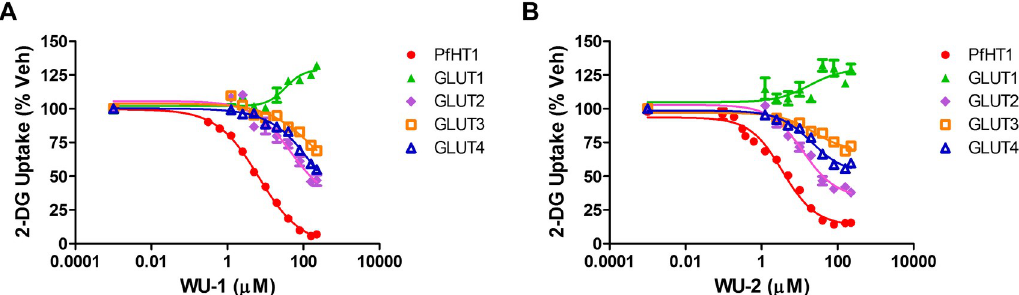
Fig 3. IC 50 determination of glucose uptake by HEK293 cells overexpressing human class I orthologues. 2-DG uptake in response to increasing WU-1 (A) or WU-2 (B) concentrations in HEK293 cells expressing the indicated GLUT protein. IC 50 s were calculated using nonlinear regression analysis using GraphPad Prism 6.0 and are tabulated in Table 1. Uptake data are expressed as means ± SEMs of three independent experiments performed in triplicate.